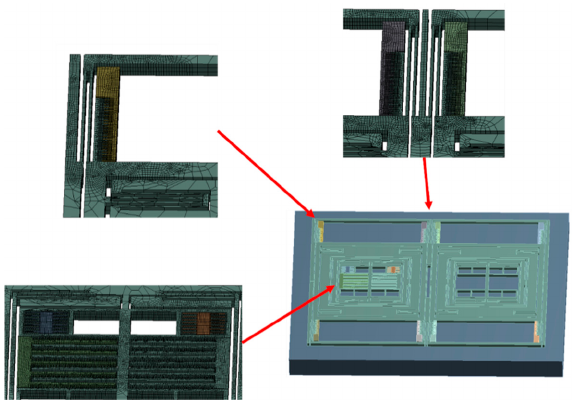
Figure 5. Simplified model and refined parts. Table 1. Material properties used in the simulation.